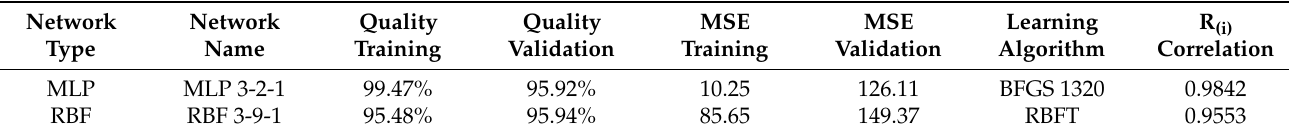
Table 3. Obtained modeling results and networks